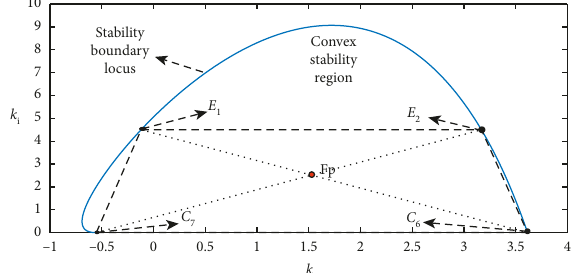
Figure 16: Convex stability region and Fermat point of PI con- troller in example D.